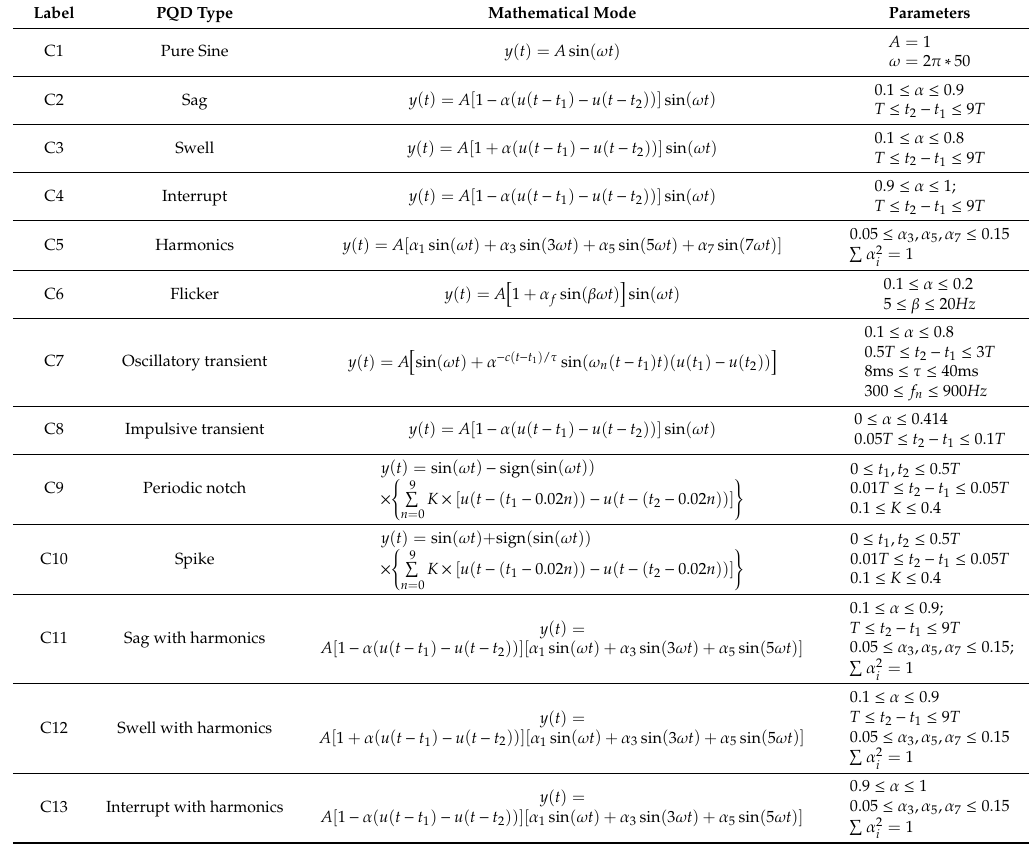
Table 1. Mathematical model of the power quality